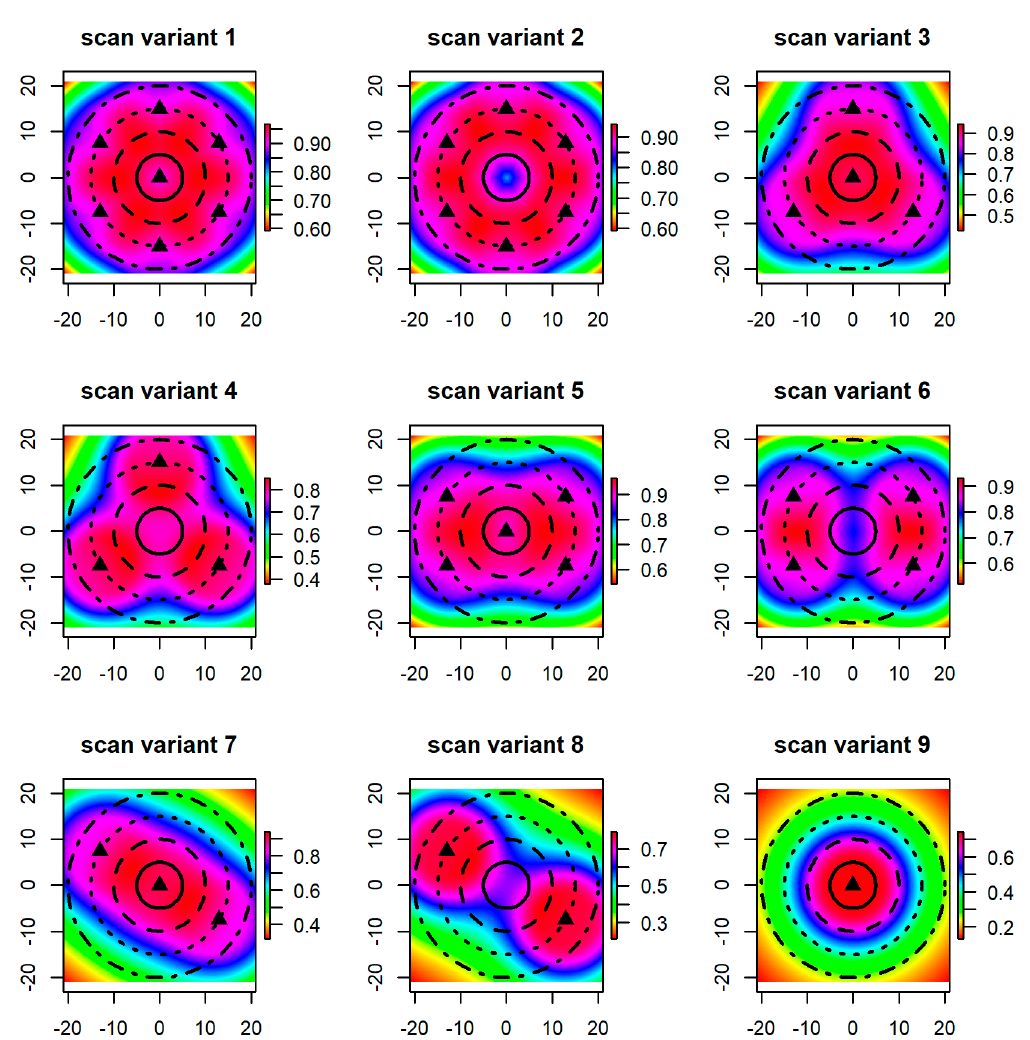
(cid:16) (cid:17) d j of large trees (dbh ≥ 20 cm) for all scan